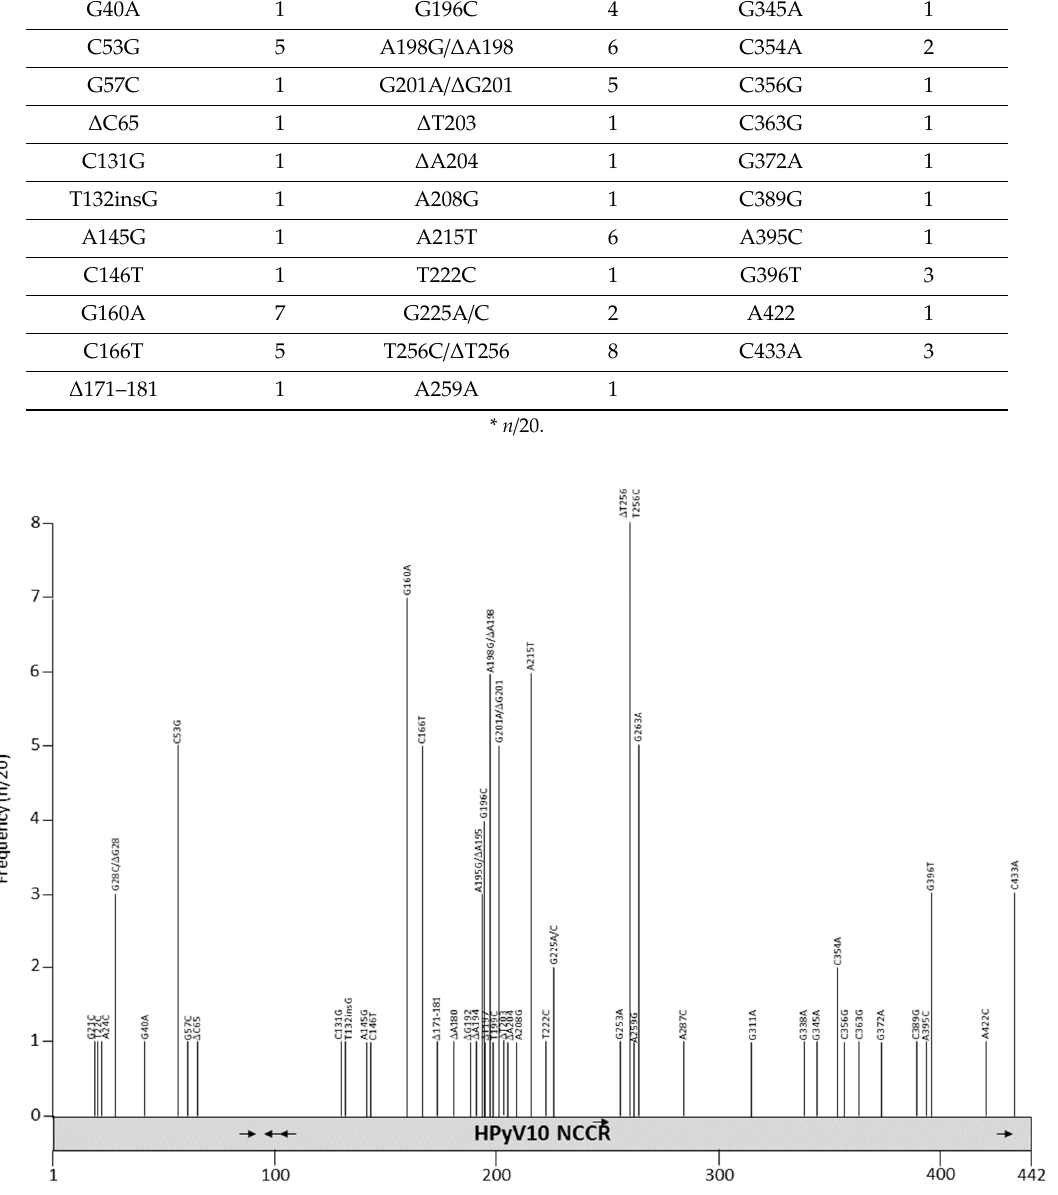
Figure 8. Mutations and their prevalence in variants of HPyV10 noncoding control region (NCCR). The numbering of the NCCR is from early to late with nucleotide 1 being the most proximal to the ATG start codon of the early genes and the most distal nucleotide, just upstream of the start codon of the VP2 gene. The number of times a peculiar mutation is found in the different variants is given as frequency (with n the number of times the mutation was described / total NCCR variant sequences available). Putative Large T antigen (LT) binding motifs 5 ′ -GRGGC-3 ′ ( → ) or 5 ′ -GCCYC-3 ′ ( ← ) are shown. The table summarizes the mutations, their location in the NCCR, and their frequency. For details see Table S1. Putative transcription factor binding sites are shown in Supplementary Table S2. Table 10. Frequency of mutations in the noncoding control region of HPyV10.